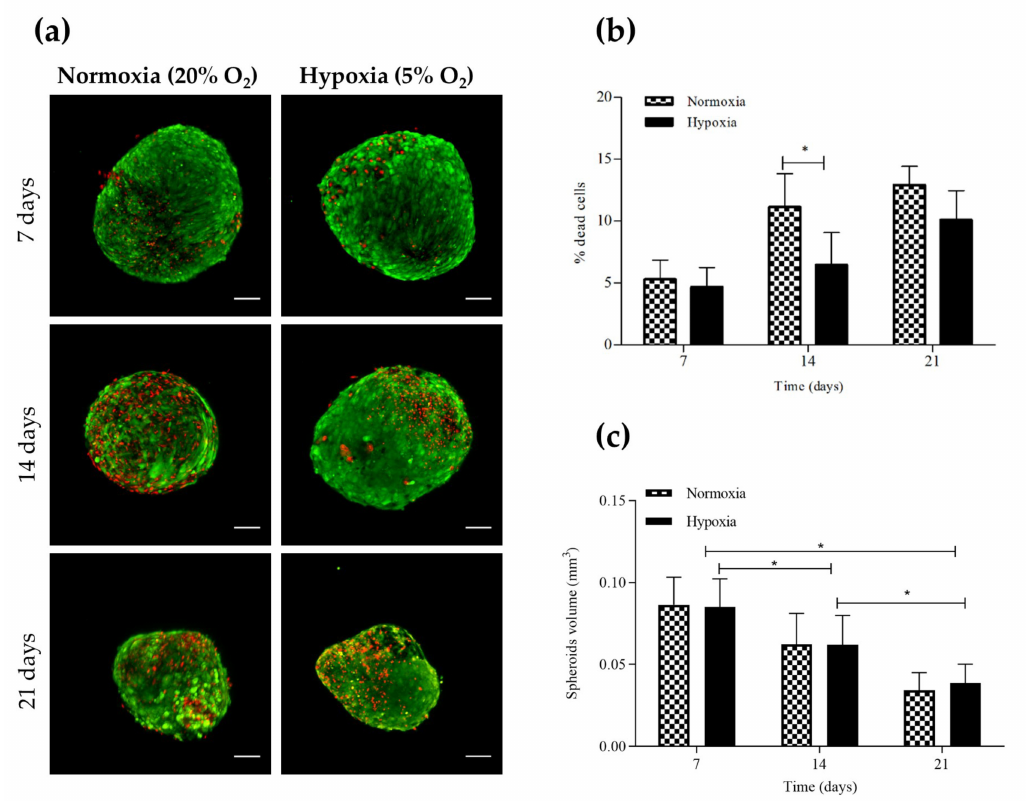
Figure 1. Chondrospheroid characterization in normoxic or hypoxic conditions at 7, 14 and 21 days. ( a ) Images of confocal microscopy showing chondospheroid cell viability assessed using Live / Dead assay ( n = 4–8 per time and culture condition); ( b ) Percentage of dead cells in chondrospheroids cultured in normoxia or hypoxia at 7, 14 and 21 days ( n = 4–8 per time and culture condition); ( c ) Spheroid volume quantification ( n = 50 per time and culture condition). The scale bar represents 100 µ m. Two-way ANOVA and Bonferroni correction was performed for the statistical analysis (* p <